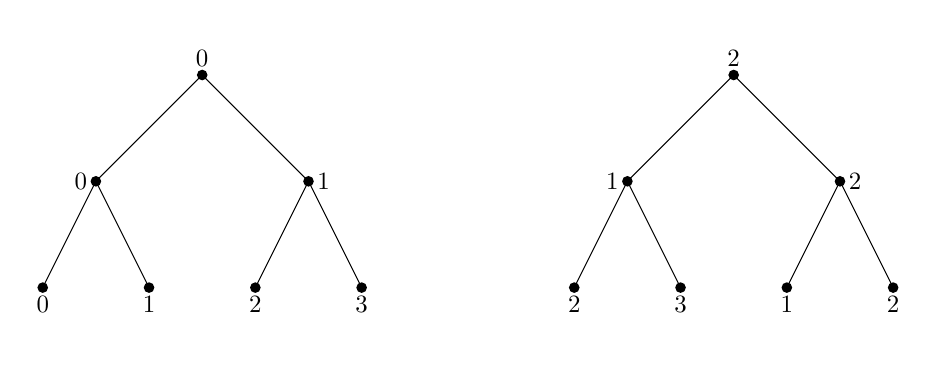
Figure 5: T B ( π, 0 , 2) and T ( π, 2 , 2)